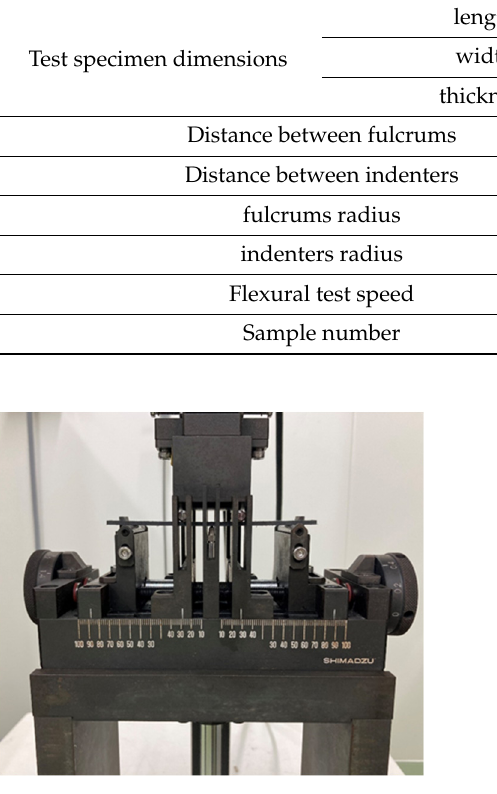
Table 7. Fiber volume fraction of each molded products.